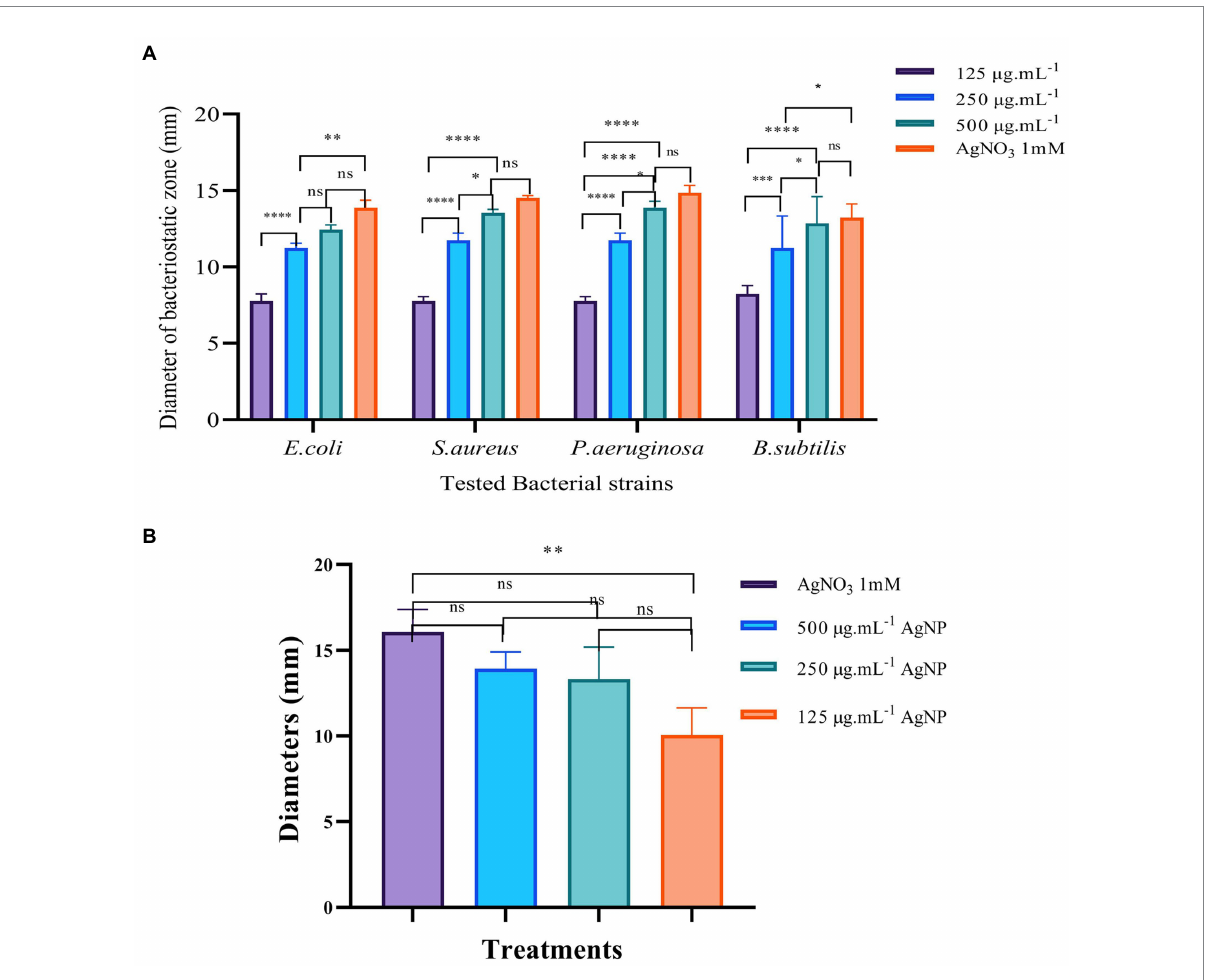
FIGURE 3 The results of bacteriostatic zone test of Mf-AgNP on four bacterial and Pectobacterium carotovorum cells. Panel (A) is the results of four model bacteria, and the Panel (B) is the results of P. carotovorum. Error bars represent standard deviation from the mean of three replicate values (ns non statistically significant difference, * p <0.05, ** p <0.01, *** p <0.001, **** p